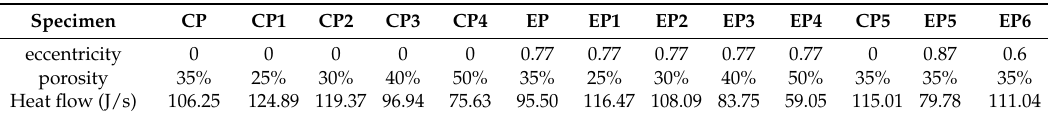
Figure 10. Porosity and minimum width effect on the heat flux and heat flow (in J/s): ( a ) porosity effect on the heat flow; ( b ) minimum width effect on the heat flow; and, ( c , d ) contour of the heat flux distribution. Table 5. Comparison of the heat flow under different